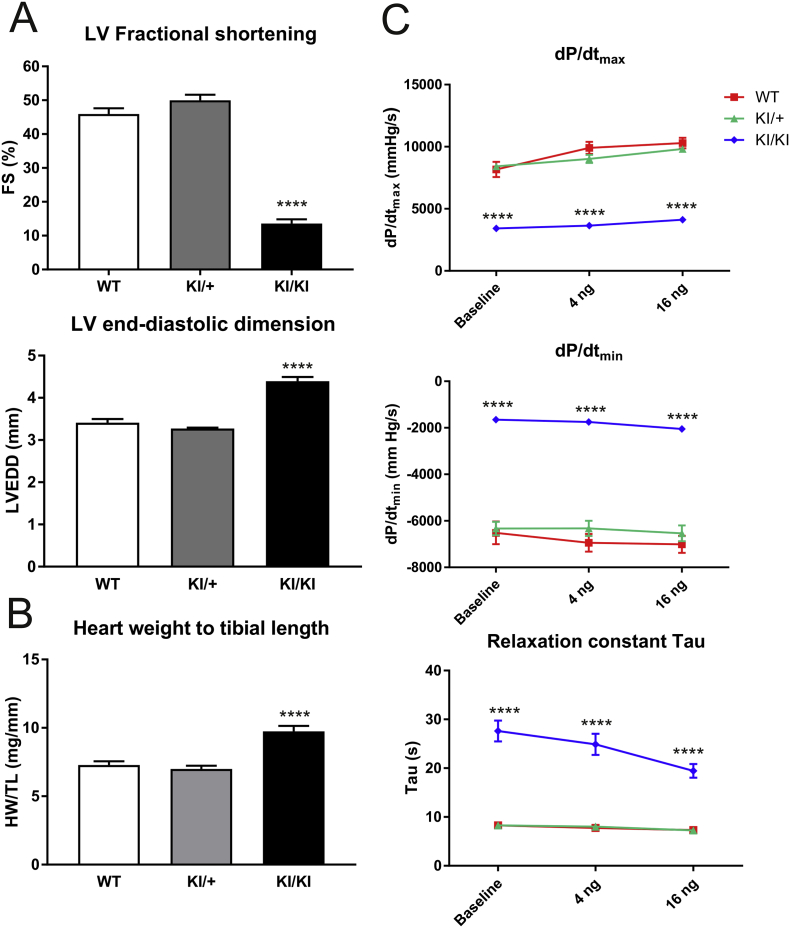
Cardiac phenotype of KI/+ and KI/KI mice in comparison to WT mice. A – Characterisation of cardiac dimensions and function by echocardiography: Fractional shortening and end-diastolic dimensions are shown. For cohort characteristics and a wider set of echocardiographic parameters please refer to Table S1. B – Heart weight is increased in KI/KI mice, values are normalised to tibial length. ****p < 0.0001 versus WT. C – Invasive haemodynamic assessment of LV performance of the three genotypes: dP/dtmax, dP/dtmin and relaxation constant Tau are shown at baseline conditions, and under adrenergic stress (dobutamine infusion at 4 ng g−1 BW min−1 and 16 ng g−1 BW min−1). Where error bars are missing, they are smaller than the symbols. For cohort characteristics and a wider set of parameters refer to Table S2.